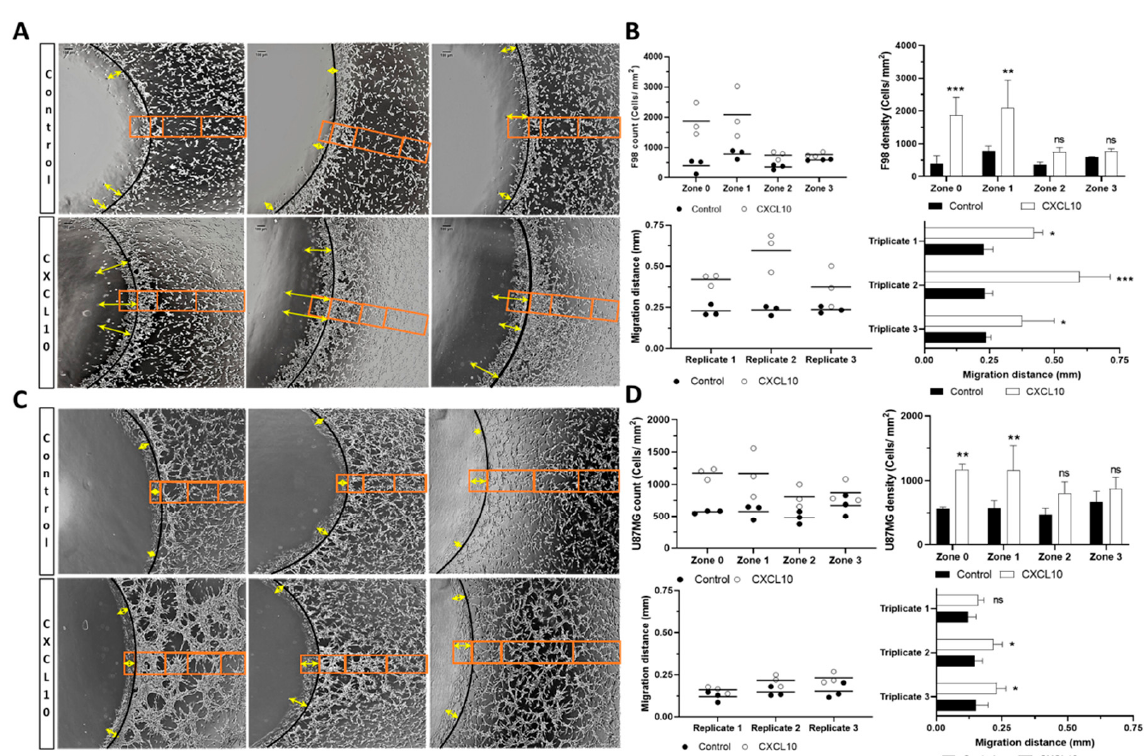
Figure 1. Measurement of chemotactic response for F98 and U87MG tumor cells. ( A ) Triplicate results of F98 cells obtained for chemotactic potency (orange box) and migration distance inside the agarose drop (yellow double arrow) in control condition or with CXCL10 in the environment. Cells located near the control drop which contains only PBS (Control) show a lower migration behavior than the cells in presence of the CXCL10 released by the agarose drop. ( B ) UPPER SEGMENT-Individual ( left ) and average ( right ) triplicate counts of cells in different zones of the control and the drop containing CXCL10 for F98 cells. LOWER SEGMENT-Individual ( left ) and average ( right ) triplicate value for migration distance inside the control and CXCL10 drop for the F98 cells. ( C ) Same as in ( A ) but for U87MG cells. ( D ) UPPER and LOWER SEGMENT-Same as in ( B ) but for the U87MG cells, n = 3 for each condition. *, p < 0.05, **, p < 0.01, ***, p < 0.001, ns, not significant. The asterisk is added above the value that is compared to the control on the left (B) or it is added next to the value that is compared to the control below (D).